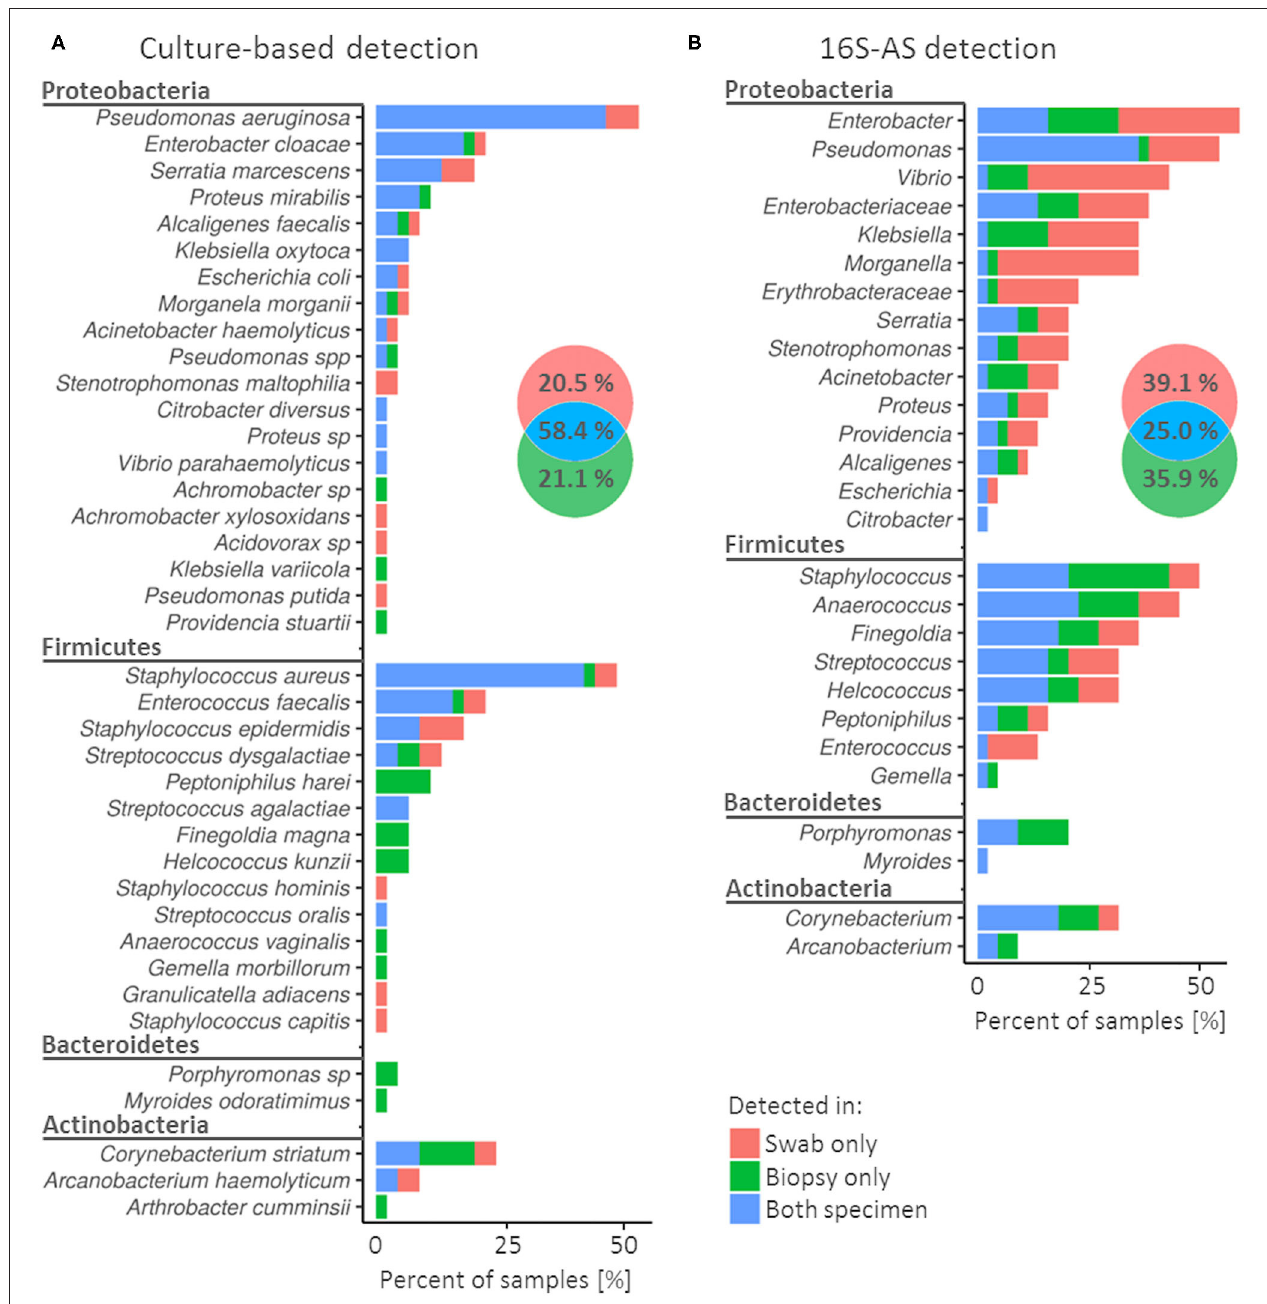
FIGURE 1 | Concordance in the detection of bacterial species (cultivation) or genera (16S-AS) in swabs and biopsy specimens obtained from chronic wounds. Colors in the frequency histograms denote the percentages of samples according to the matching/non-matching detections between swab/biopsy sample pairs of the same CW. Results are presented for cultivation-based approach (A) and 16S-AS (B) , separately. Venn diagrams show cumulative percentages for all detected bacterial groups. Note that (A) (cultivation) represent diversity at the species taxonomic level while (B) (16S-AS) at the genus taxonomic level, therefore the direct comparison of detectable diversity between methods is not possible in this